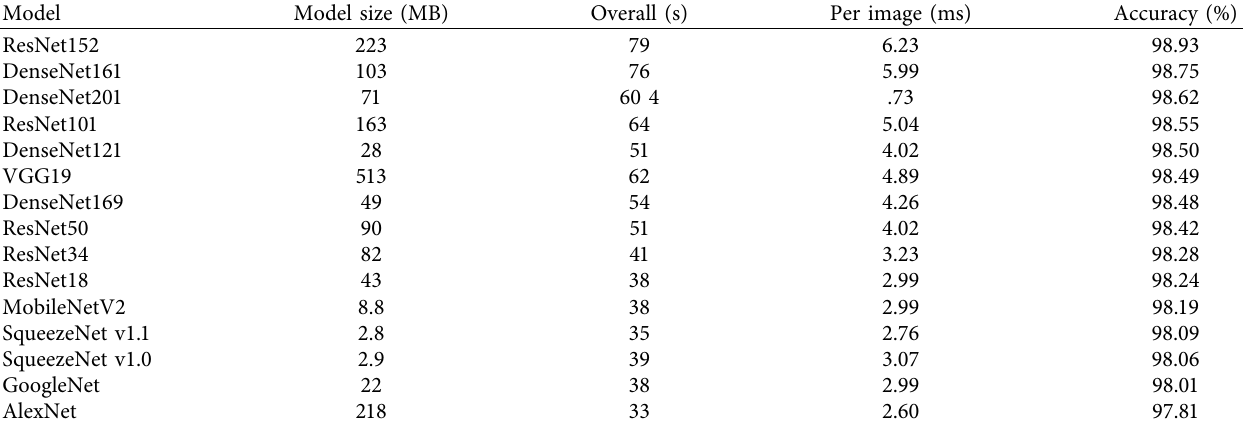
Table 2: Accuracy of a masked face classification model.